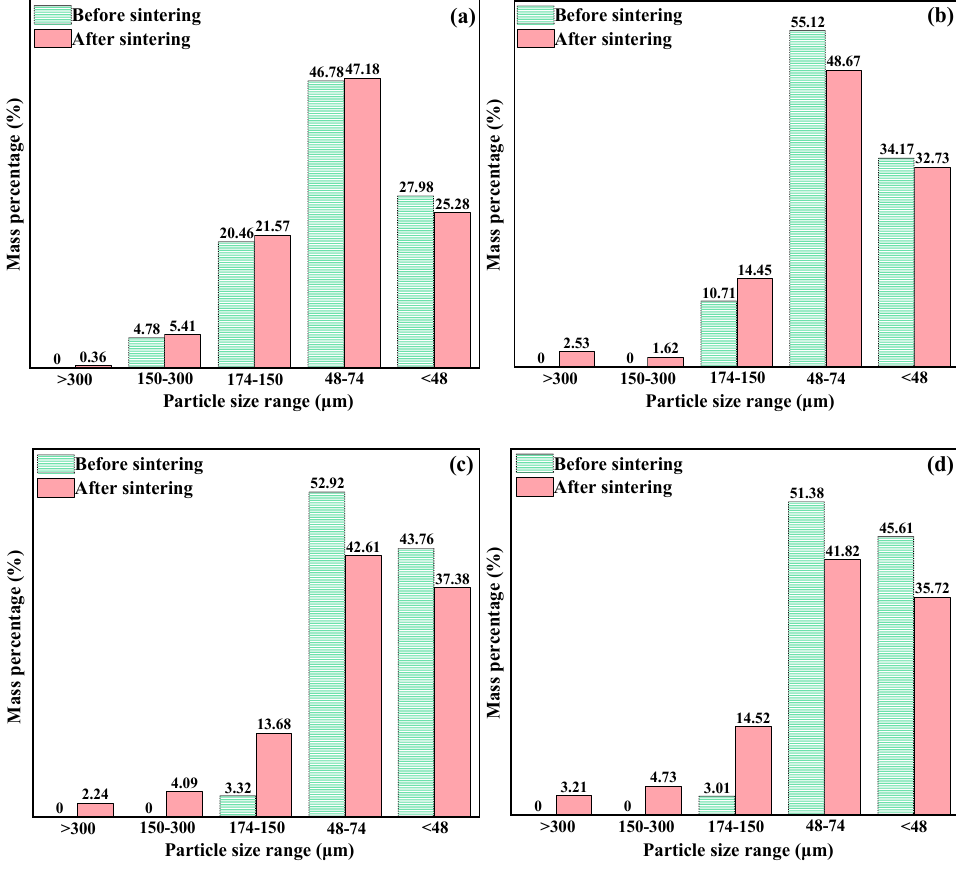
Figure 4. Cathode particle size distribution of mixed oxides after different ball-milling times. (( a ) 8 h, ( b ) 10 h, ( c ) 12 h, ( d ) 14 h).